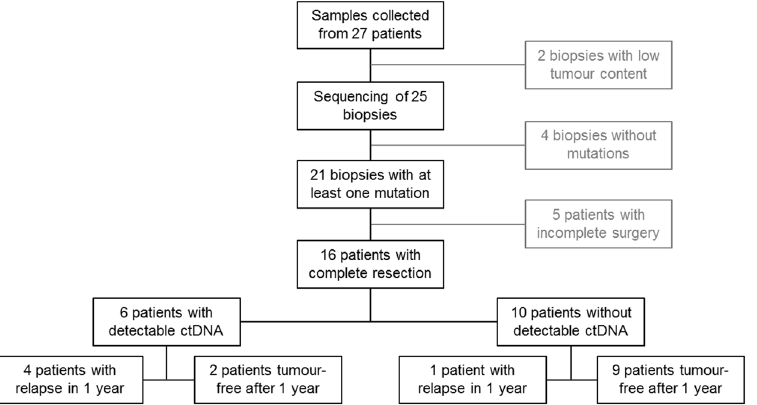
Figure 1. Study Workflow showing respective sample numbers for each analysis step. Methodical comparison of next-generation sequencing vs. digital droplet PCR for the detection of tumour DNA in plasma is performed on data of 21 patients with identified mutations. Clinical outcome analysis is performed for 16 patients as five patients had to be excluded due to incomplete